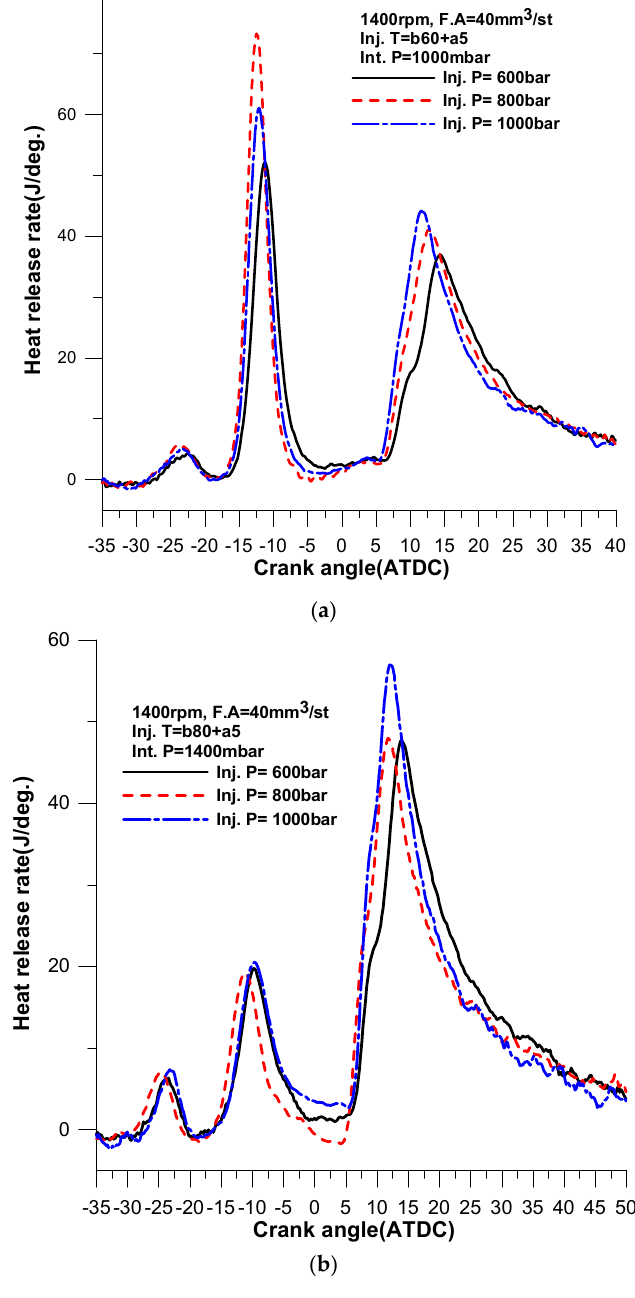
Figure 12. Characteristics of the heat release rate in accordance with change the boost pressure. ( a ) Injection timing, 1st injection BTDC 60CA 2nd injection ATDC 5CA, charging pressure = 1000 mbar; ( b ) Injection timing, 1st injection BTDC 60CA 2nd injection ATDC 5CA, charging pressure = 1400 mbar.